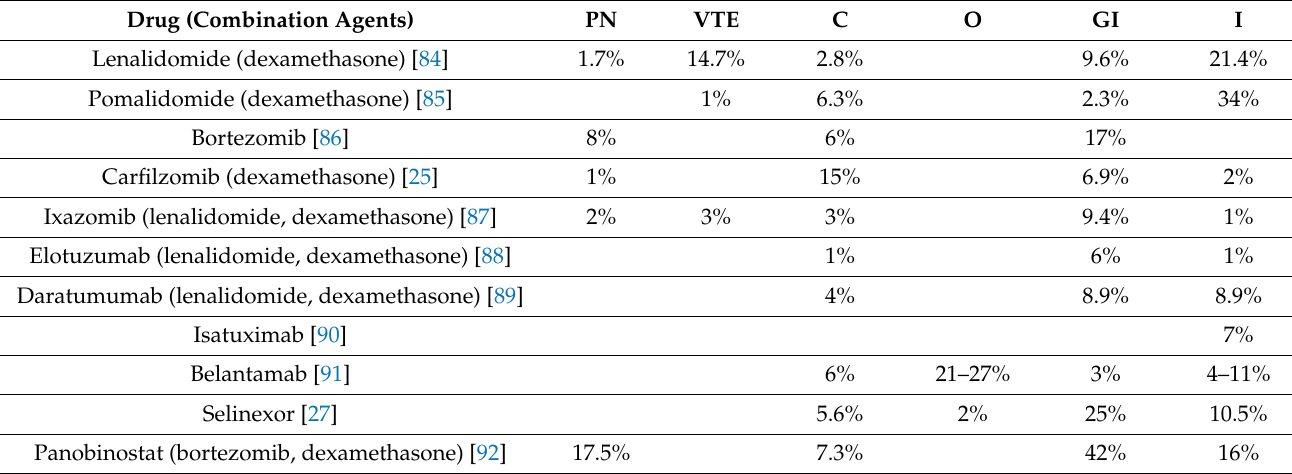
Table 3. Extra-hematological Grade 3/4 adverse events of specific interest in